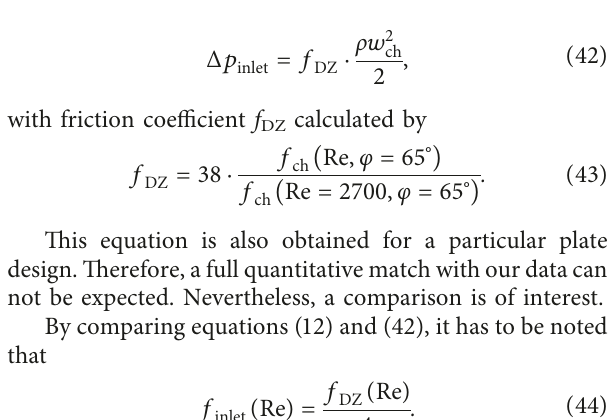
Figure 14: Inlet pressure drop ratio IR corrugated field.